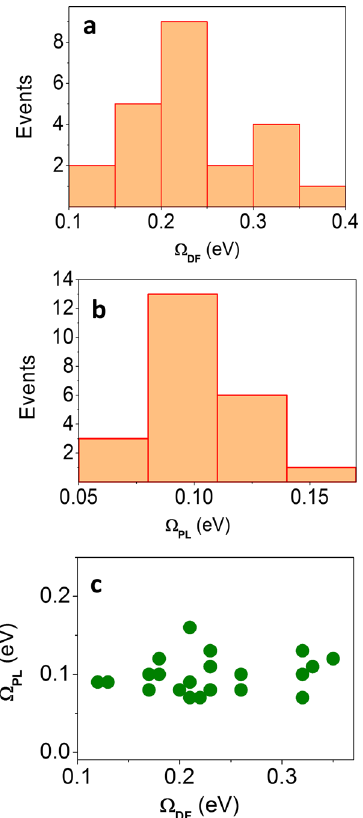
Fig. 2 Peak splittings in scattering and PL. a , b Histograms of peak splitting values obtained from dark- fi eld scattering spectra, Ω DF ( a ) and from PL spectra, Ω PL ( b ). c Correlation between splitting values in PL and in scattering.